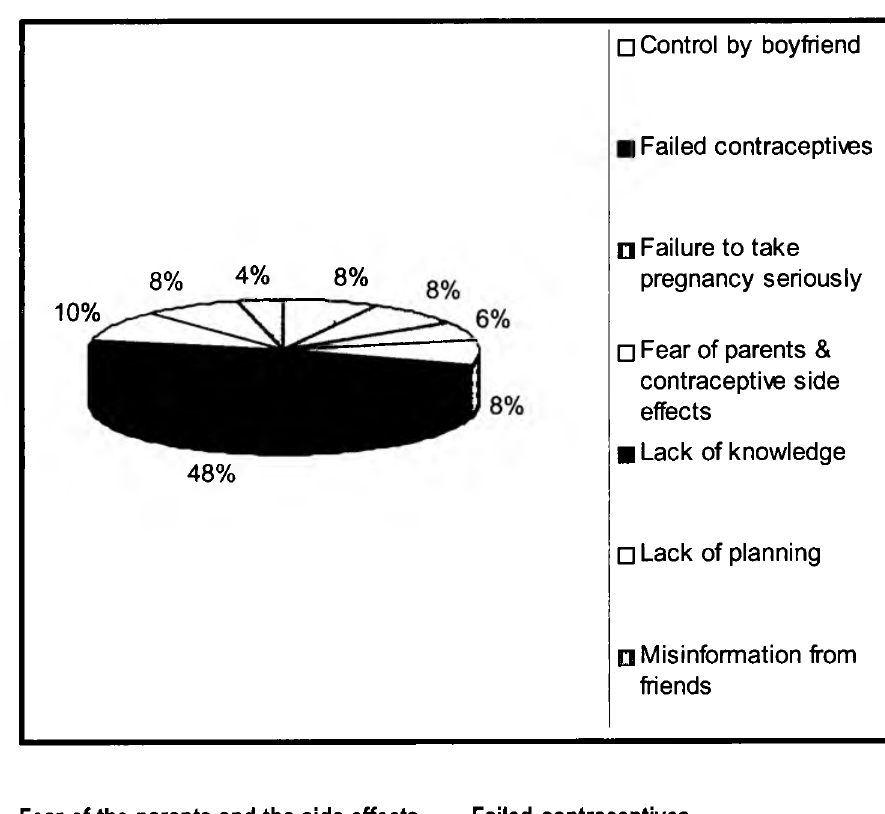
Figure 1: Reasons for